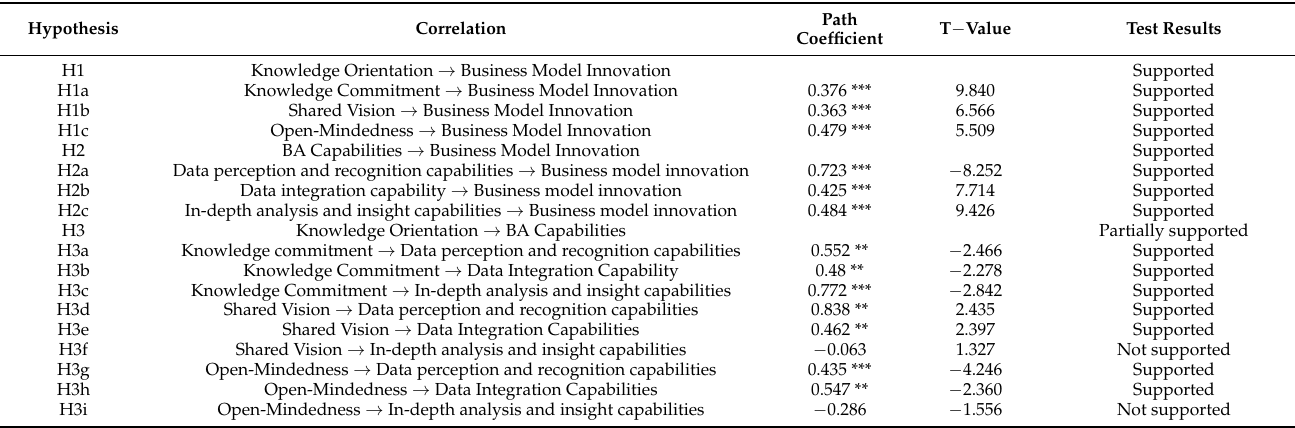
Table 4. Results of path coefficients and hypothesis testing.